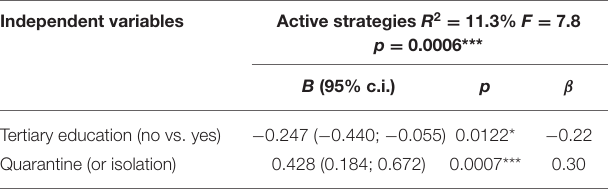
TABLE 8 | MiniCope strategies among nurses in Poland who have undergone home isolation or